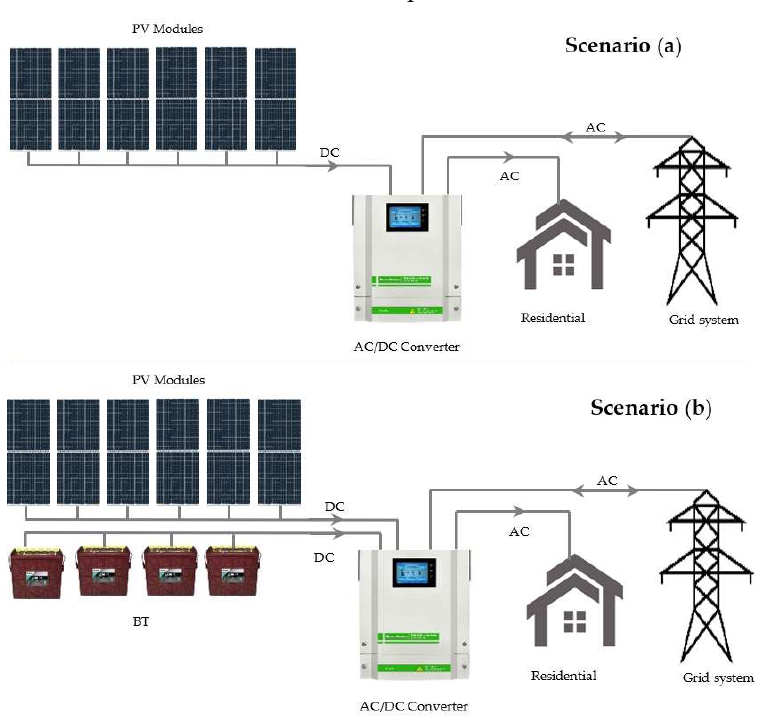
Figure 1. The energy system scenarios: ( a ) PV array only, ( b ) PV + BT.